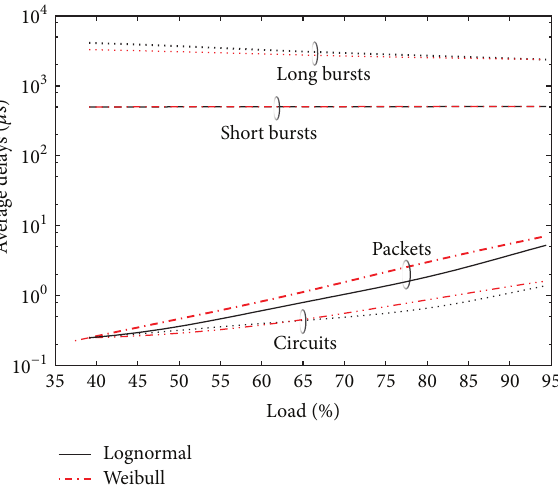
Figure 6: Average data loss rates in the HOS network as a function of the number of servers in the data center. Two different values for the input load, namely, 65% and 80%, are considered.